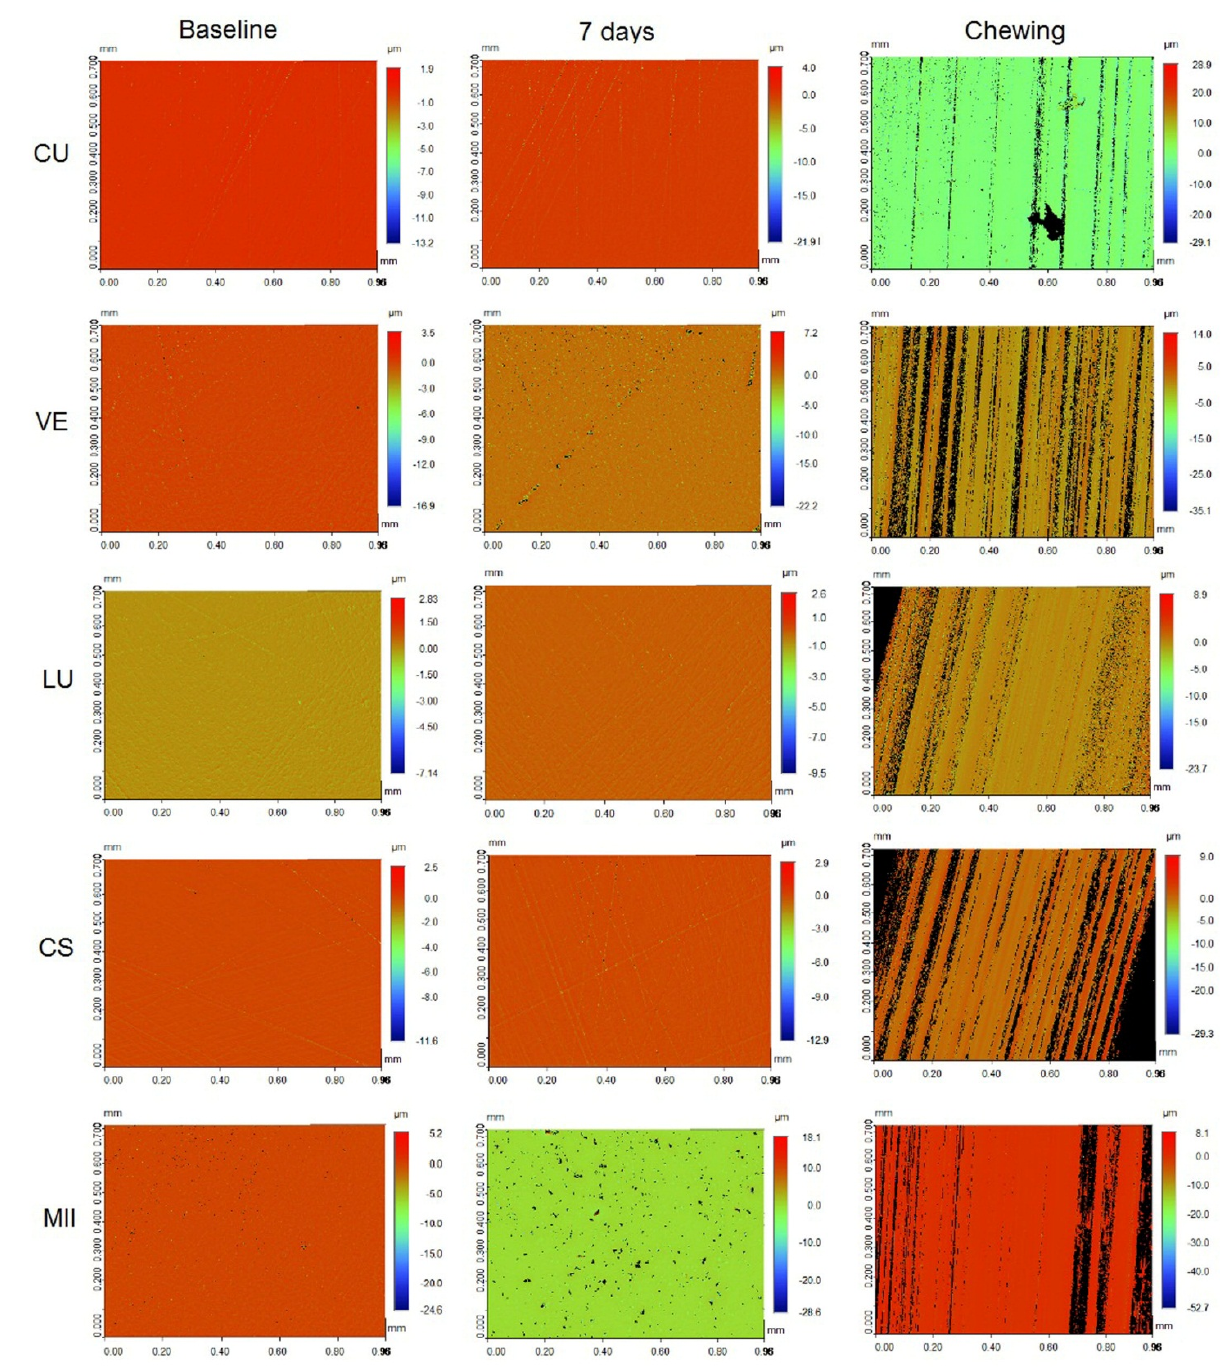
Figure 6. Profilometer images of the CAD/CAM specimens immersed in cola at different measure- ment intervals.